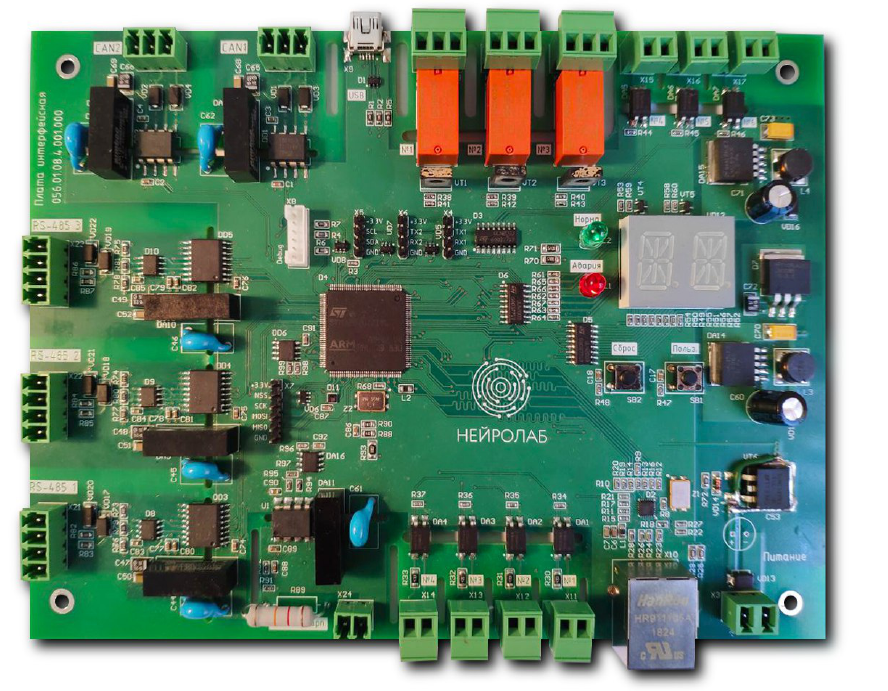
Figure 5. AnyWalker control computing